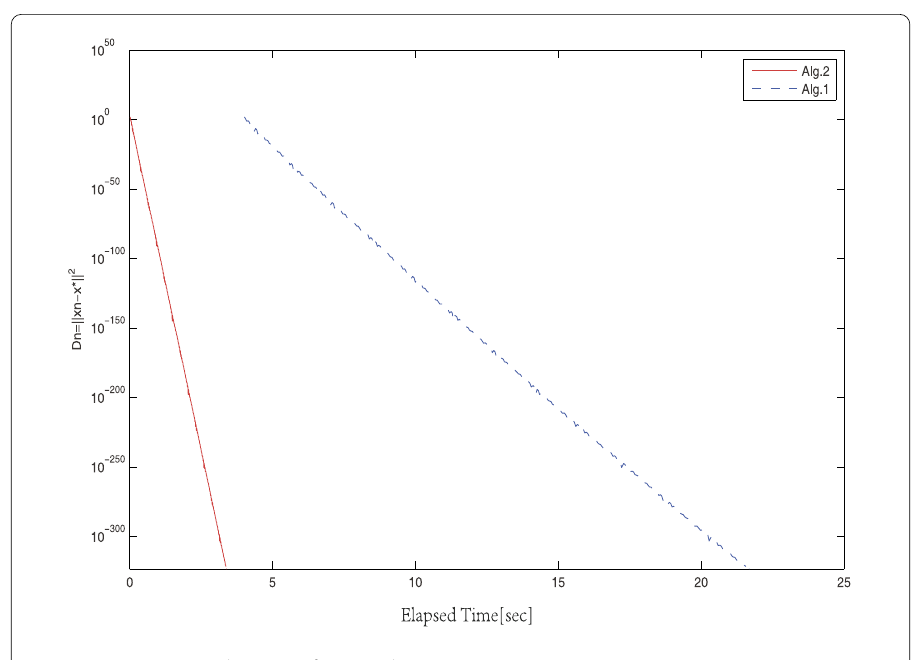
Figure 4 Experiment with m = 100 for Example